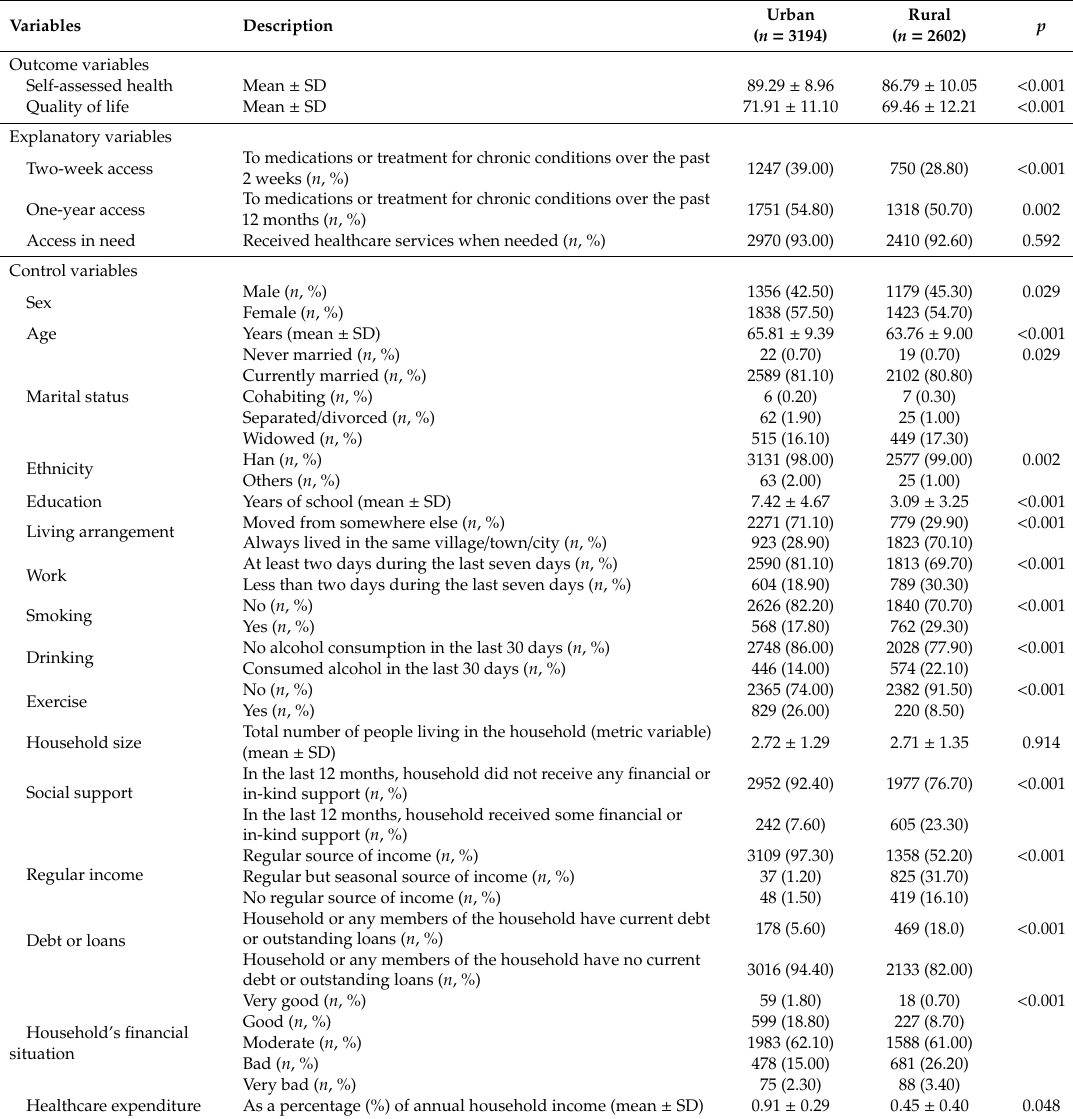
Table 1. Description of variables and general characteristics of